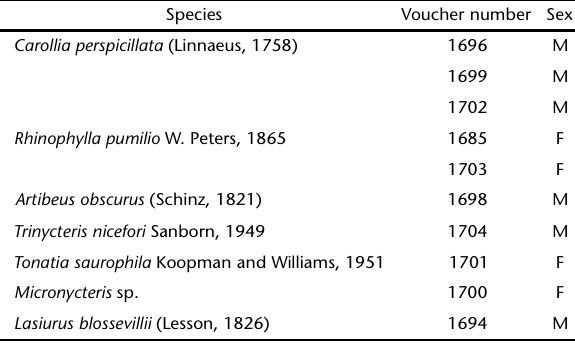
Table I. Bat species and voucher number of individuals deposited in the Mammal Collection of the Universidade Federal de